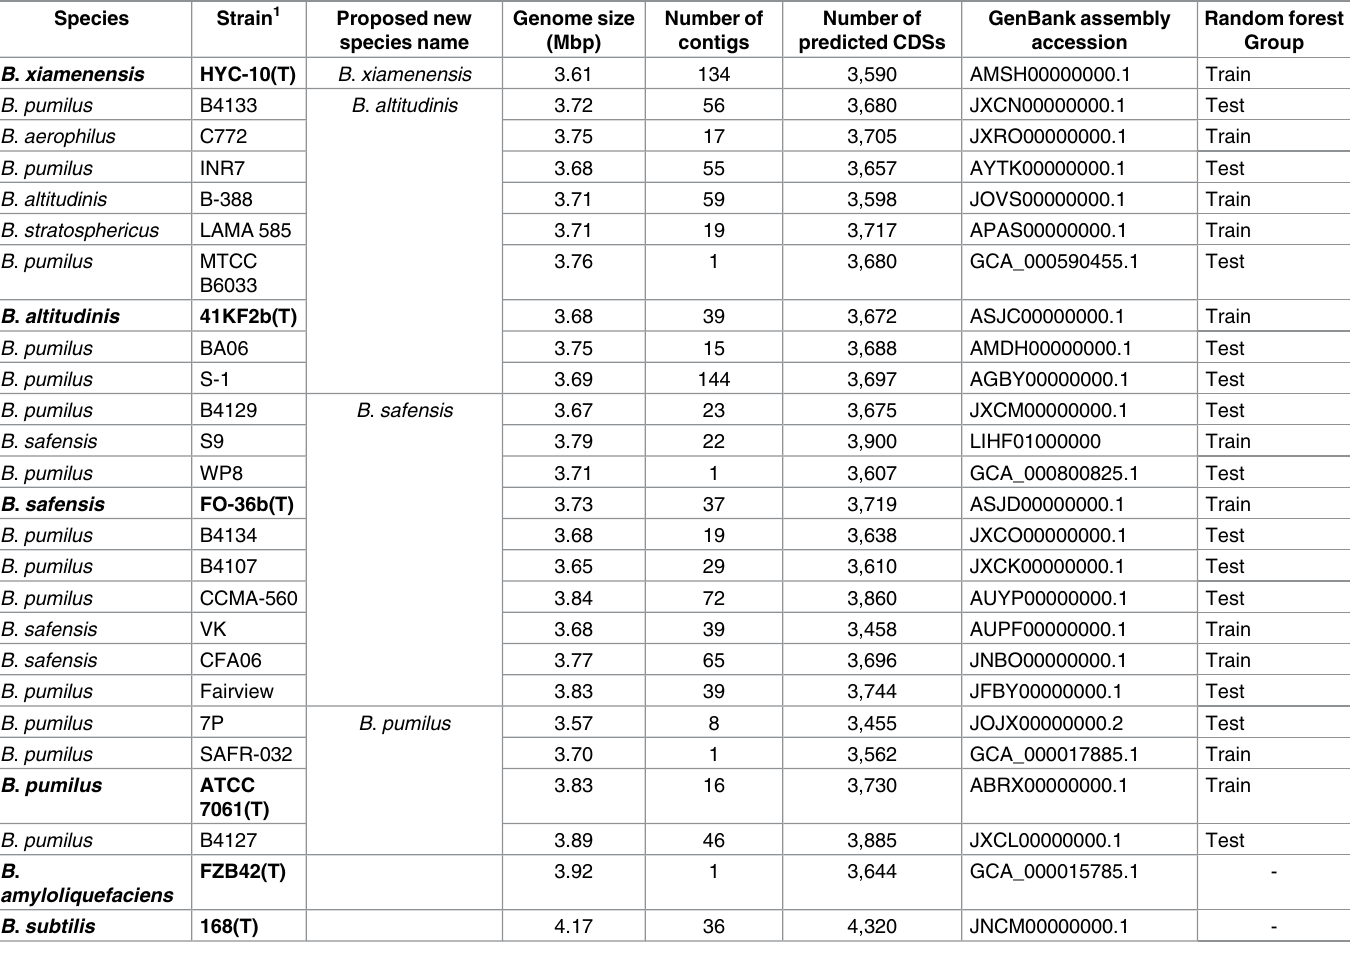
Table 1. Proposed species names and assembly data for strains used for pipeline construction and testing.